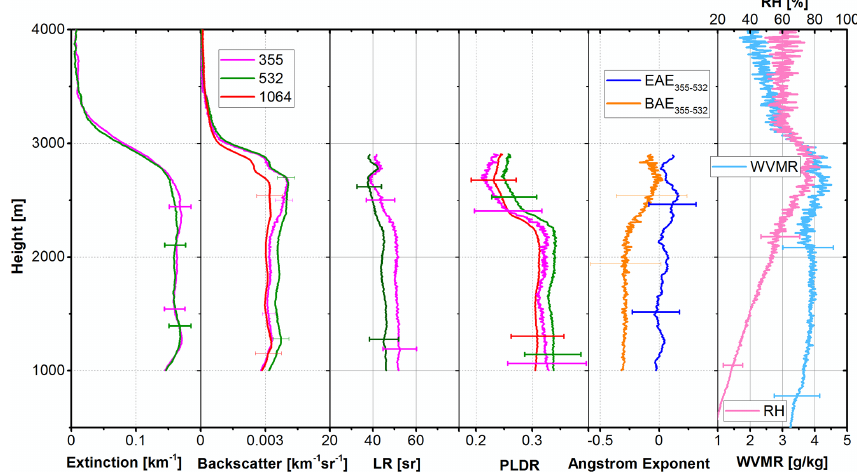
Figure 10. Case 3: lidar-derived parameters at 18:00–20:00UTC, 15 April 2019. (a) Extinction coefficient, (b) backscattering coefficient, (c) lidar ratio, (d) PLDR, (e) EAE 355 − 532 and BAE 355 − 532 , and (f) WVMR and